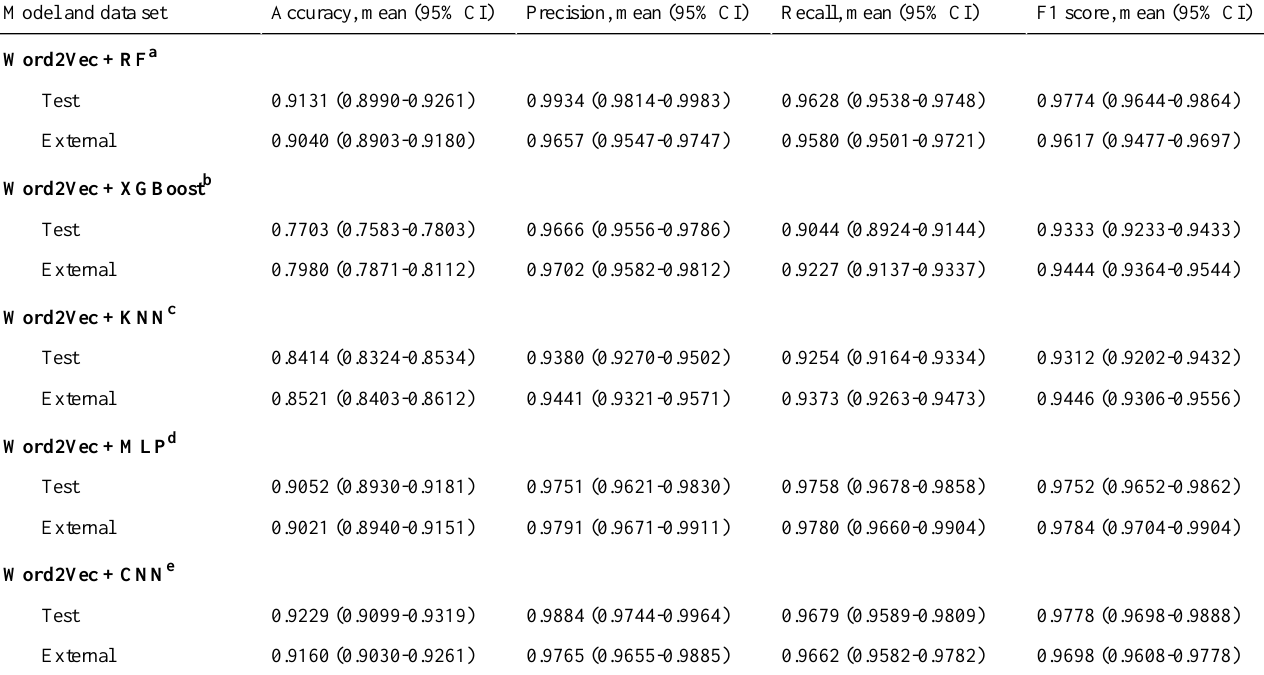
Table 3. Performance analysis of model-based reasoning methods in combination with rule-based reasoning methods applied for syndrome pattern diagnosis of lung disease based on Word2Vec in the test and external data